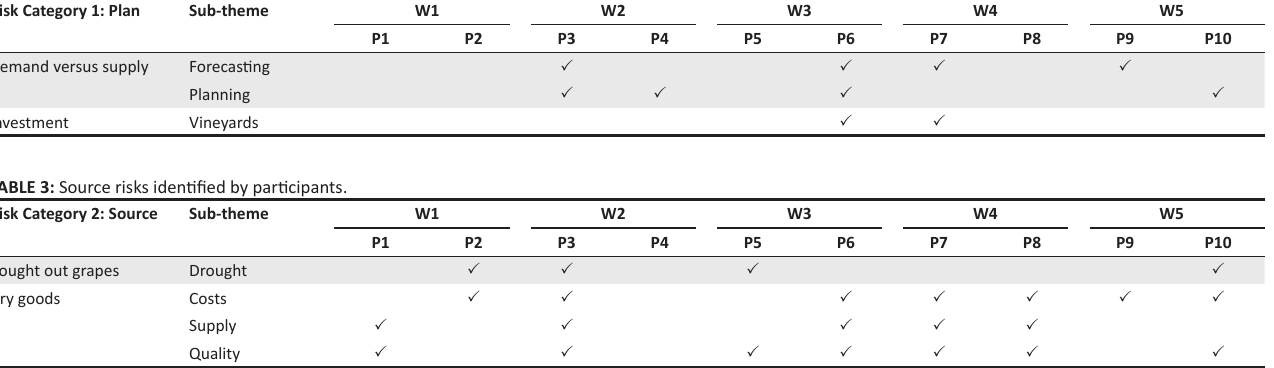
TABLE 2 : Plan risks identified by participants. Risk Category 1: